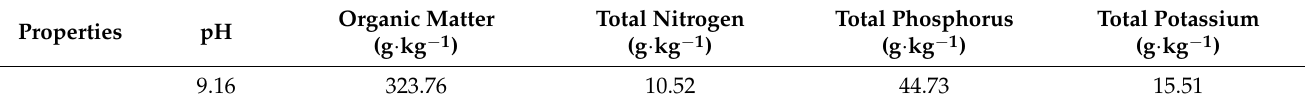
Table 4. Properties of the biochar.